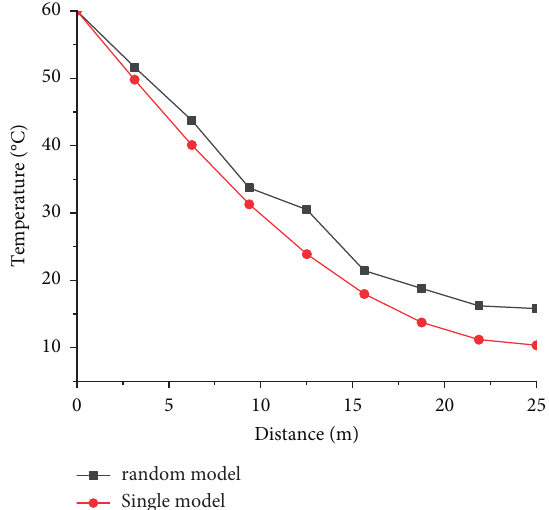
Figure 4: Single model vs. random model temperature comparison chart.